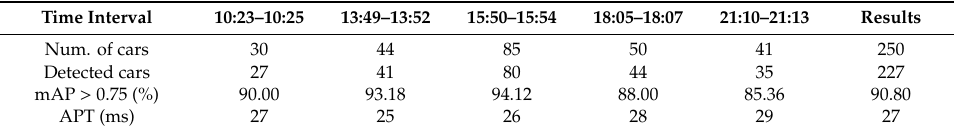
Table 1. Detection network evaluation